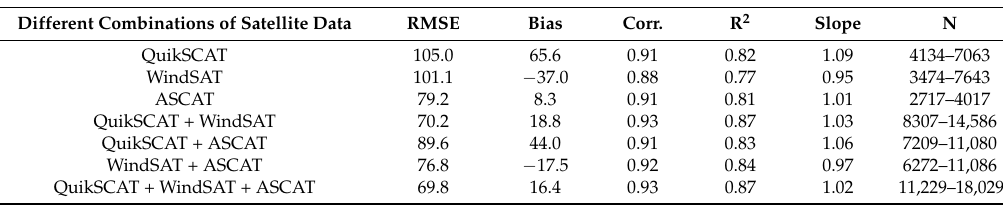
Table 5. Statistics of the comparison between buoy-derived WPD and satellite-derived WPD (W/m 2 ) at a height of 100 m above sea level.